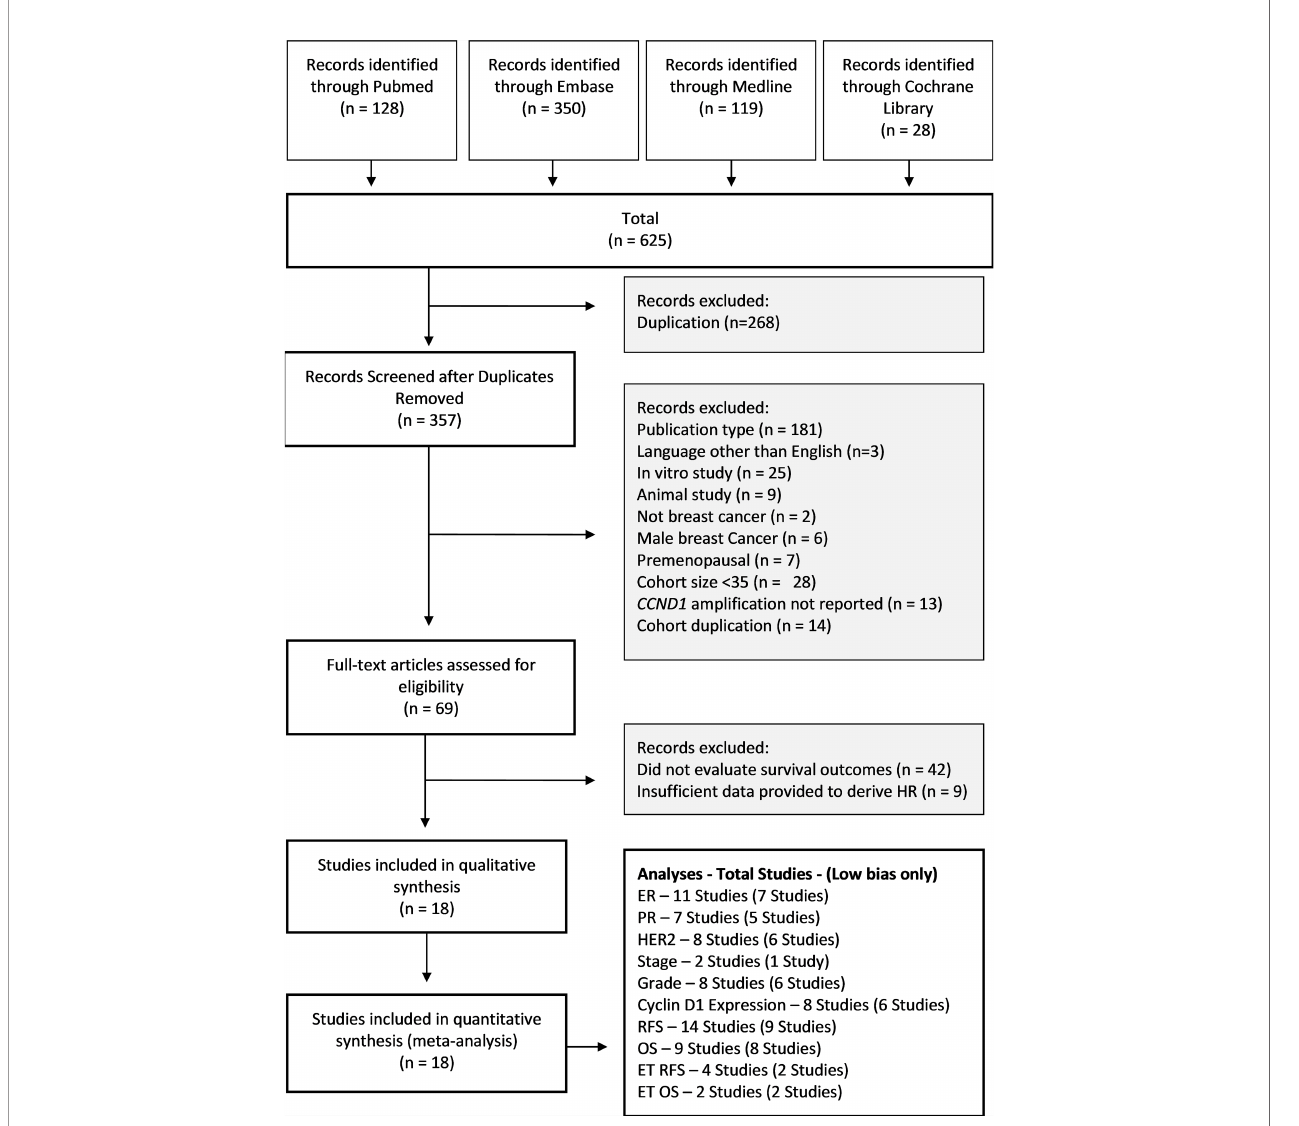
FIGURE 2 | Study Selection PRISMA Diagram. Flow diagram shows studies retrieved from databases, and the number of studies excluded and the basis on which they were excluded. OS, Overall Survival; RFS, Relapse Free Survival; HR, Hazard